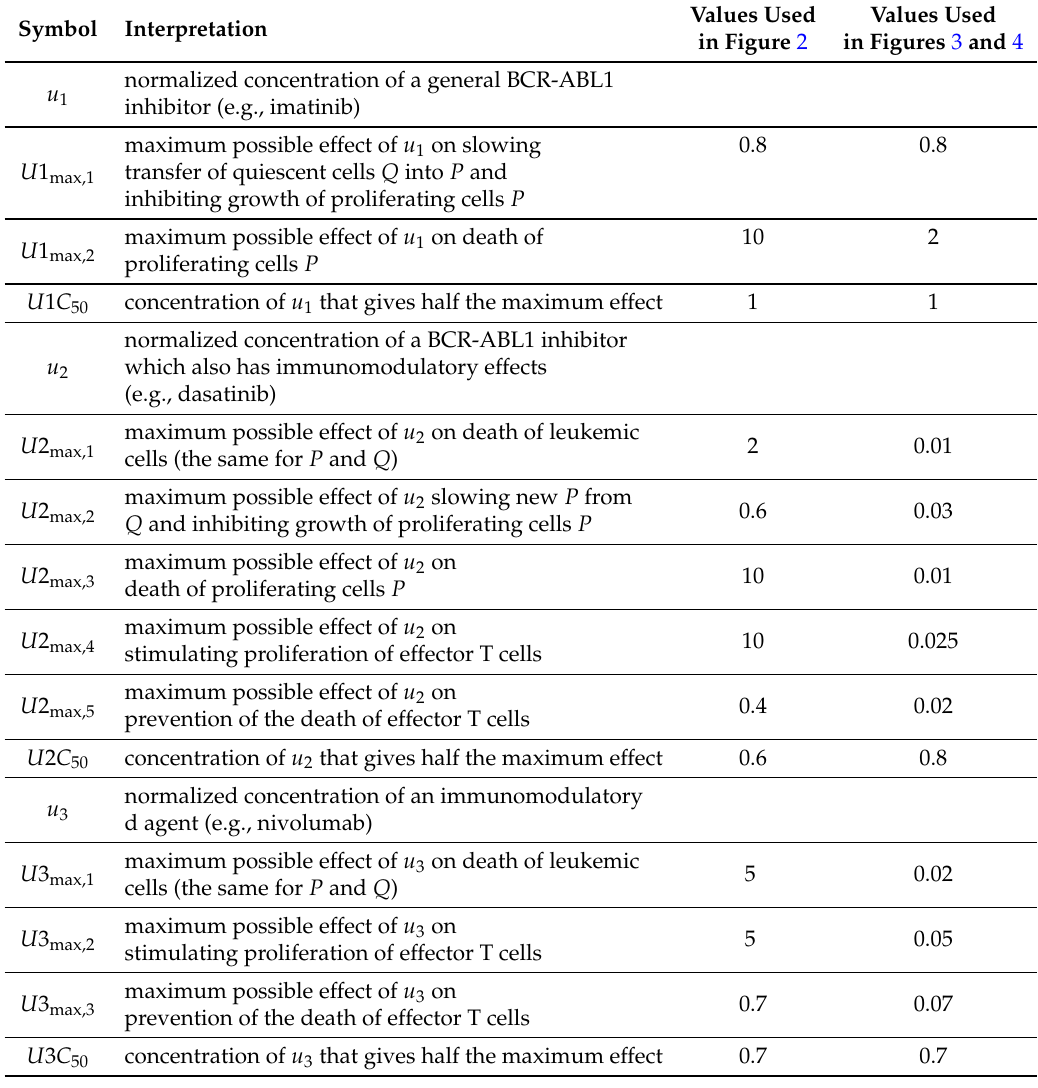
Table 2. Controls and pharmacodynamic